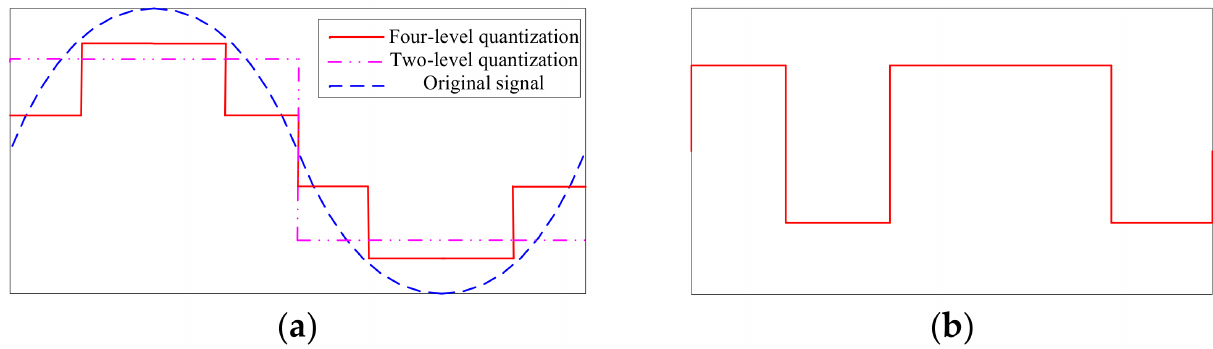
Figure 1. ( a ) Four-level and two-level quantization within one cycle of the carrier, respectively; ( b ) The binary sequence of DSSS